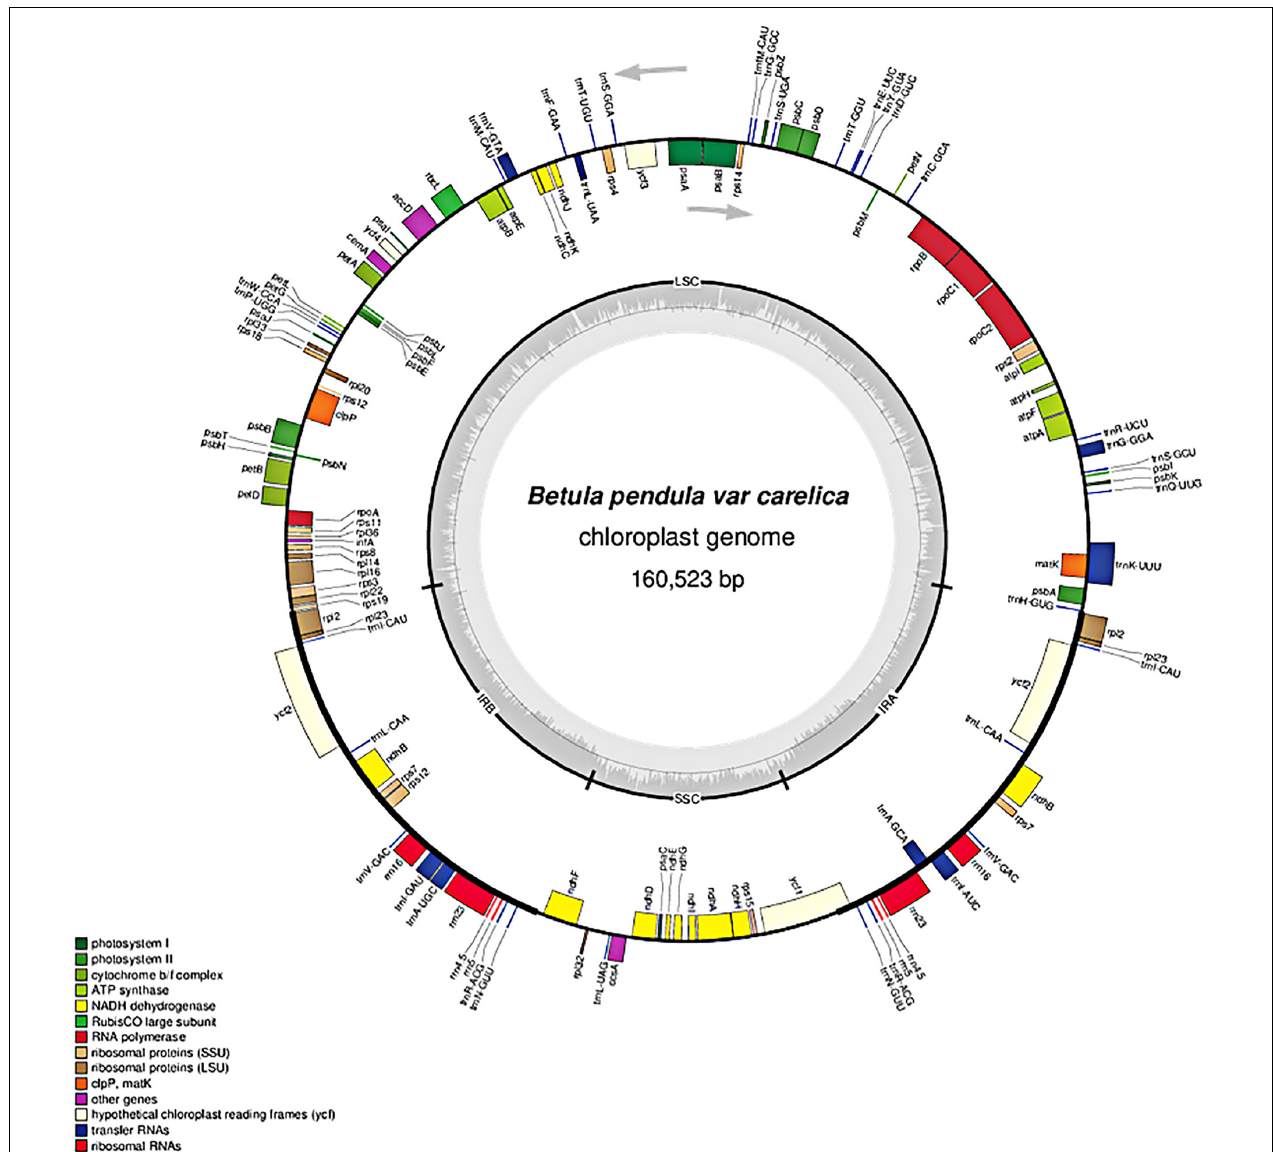
FIGURE 2 | Chloroplast genome map of Betula pendula var. carelica . Arrows indicate the transcription direction. The gray inner circle displays the GC content that corresponds to the outer circle gene map. Genes belonging to different functional groups are shown in different